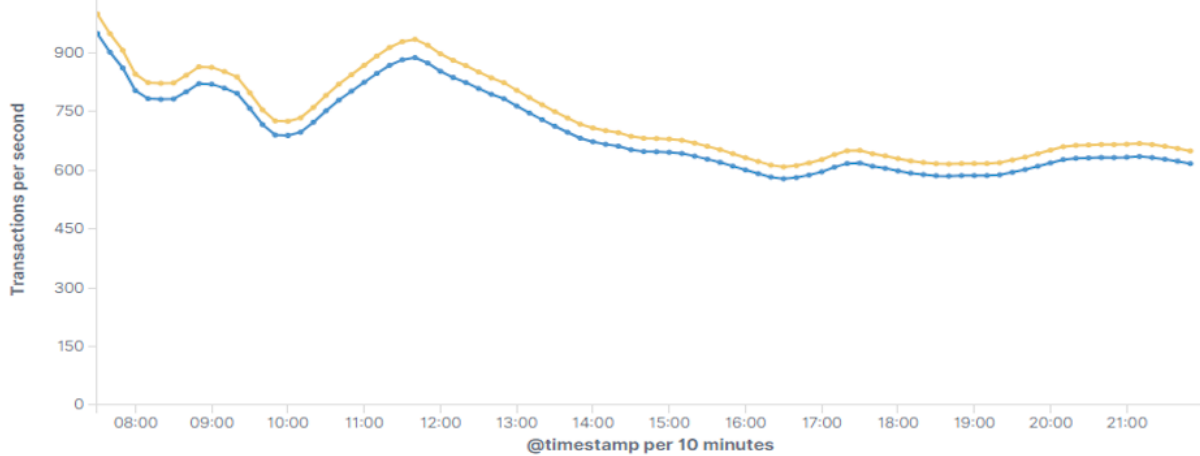
Figure 14. Average DLTs throughput: IOTA (orange) and Polkadot